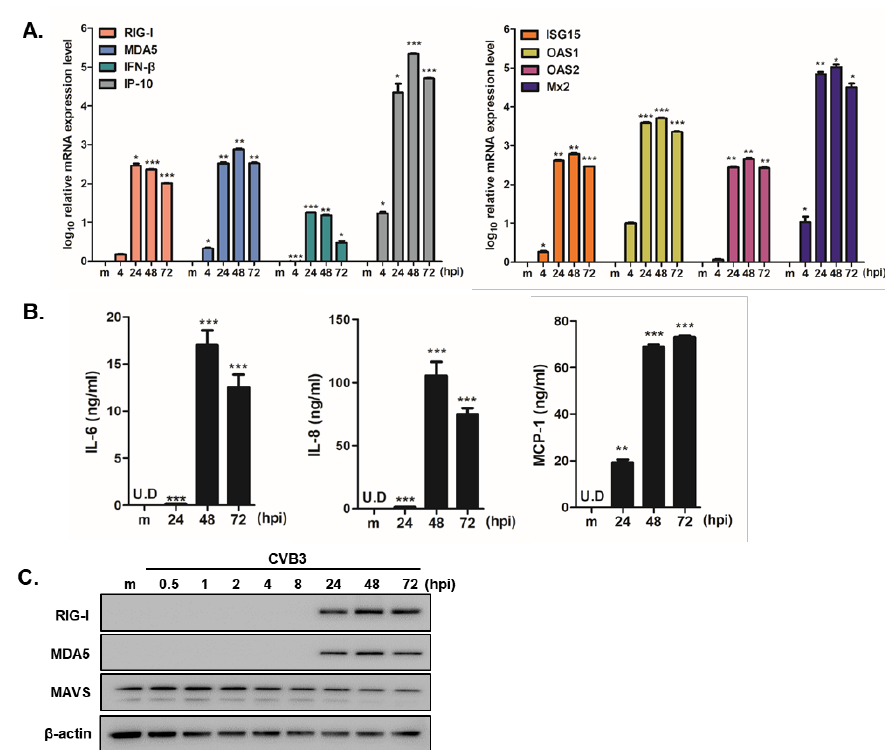
Figure 4. Interferon signaling and inflammatory responses are induced in CVB3-infected hNPCs. ( A ) Quantitative RT-PCR analysis was performed to measure RIG-I , MDA5 , IFN- β , IP-10 , ISG-15 , OAS1 , OAS2 , and Mx2 transcript levels following CVB3 infection (MOI 5) in hNPCs. * p < 0.05; ** p <